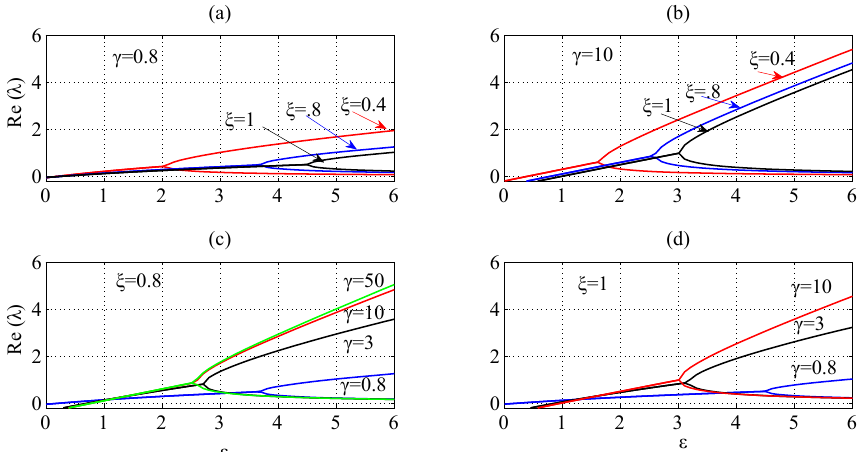
Figure 4. Loci of eigenvalues for different values of ξ and γ . The Figure shows the real part of eigenvalues as a function of parameters ε , ξ and γ . For (a) and (b) fixed γ = 0 . 8 and 10, respectively; (c) and (d) shows eigenvalues for fixed ξ = 0 . 8 and 1,